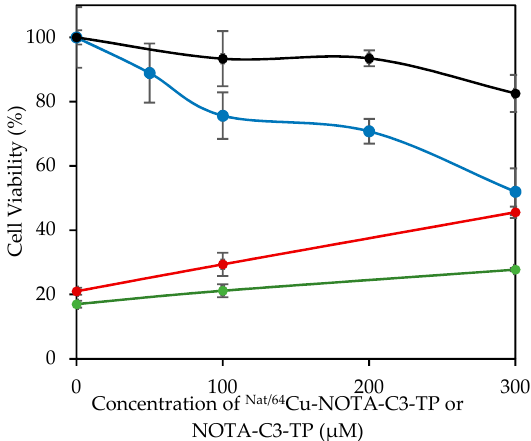
Figure 2. Cell viability of NOTA-C3-TP (black line), [ Nat Cu]Cu-NOTA-C3-TP (blue line), and [ 64 Cu]Cu-NOTA-C3-TP at 5 MBq (red line) and 8 MBq (green line) measured after 24 h incubation in HCT116 cells. Note: The addition of NOTA-C3-TP to [ 64 Cu]Cu-NOTA C3-TP at 5 MBq (red line) and 8 MBq (green line) reduced the initial molar activity of the tracer from 0.84–4 to 0.28–1.33 MBq/nmol in growth medium.